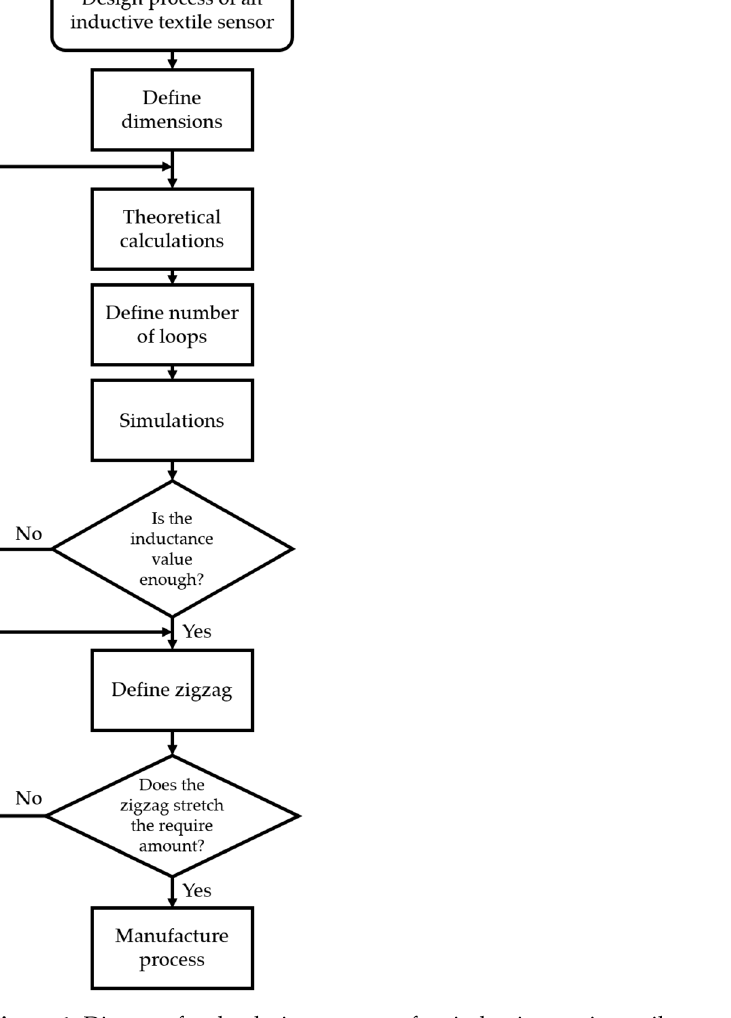
Figure 1. Diagram for the design process of an inductive strain textile sensor with a flat rectangular coil configuration.